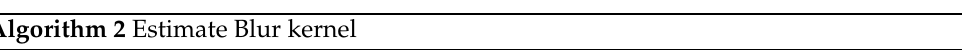
Algorithm 2 Estimate Blur